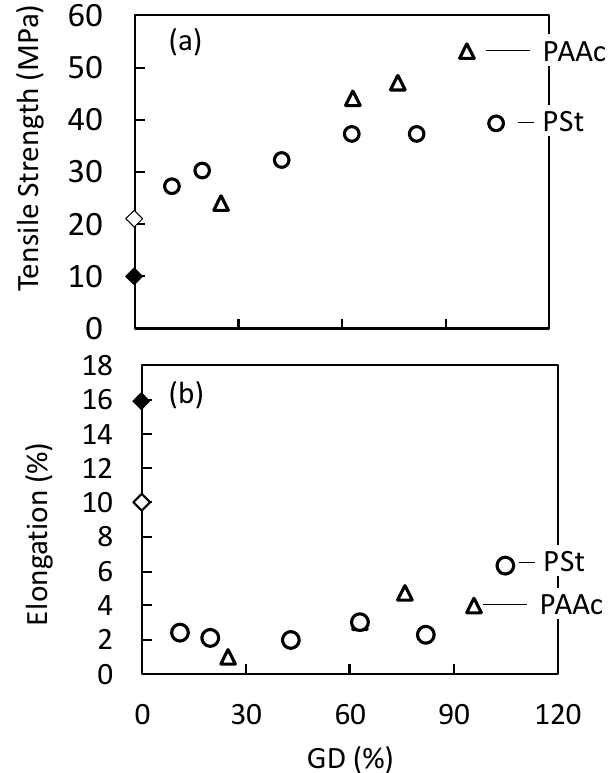
Figure 5. Tensile strength ( a ) and elongation at break ( b ) of porous PVDF membrane and grafted porous PVDF membranes before and after heat compression as a function of GD: PVDF membrane substrate before ( ◆ ) and after ( ◇ ) heat compression, and ( ⚪ ) St, ( △ ) AAc-grafted PVDF after heat